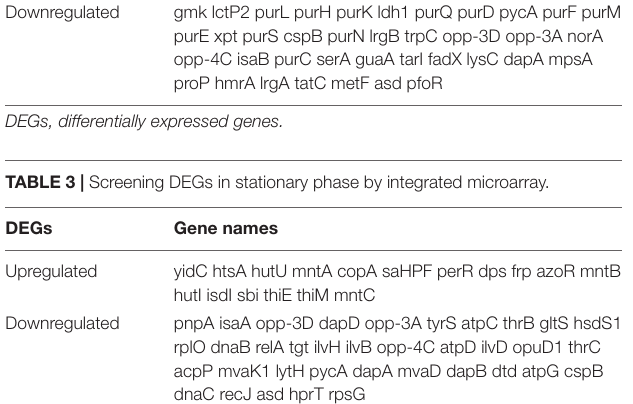
Frontiers in Microbiology |